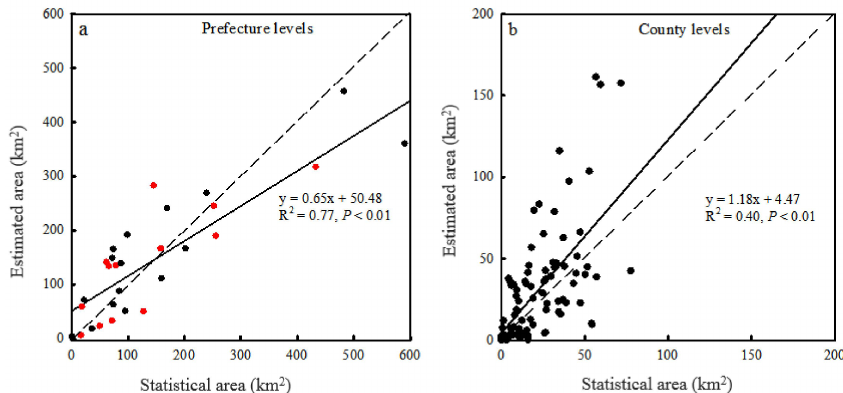
Figure 4. Comparison of irrigated areas in Northeast China, as estimated by the proposed method and statistical areas at the prefecture ( a ) and county ( b ) levels. The dotted line is a 1:1 line. The black dots in Figure 4a indicate the 18 prefectures used for developing the relationship between LSWI Diff0 and MAP, and red dots indicate the remaining 17 prefectures for verification. Statistical area refers to the data of the irrigation area in a given administrative unit (such as a prefecture or a county) that were obtained from the statistical yearbooks for Heilongjiang, Jilin, and Liaoning.